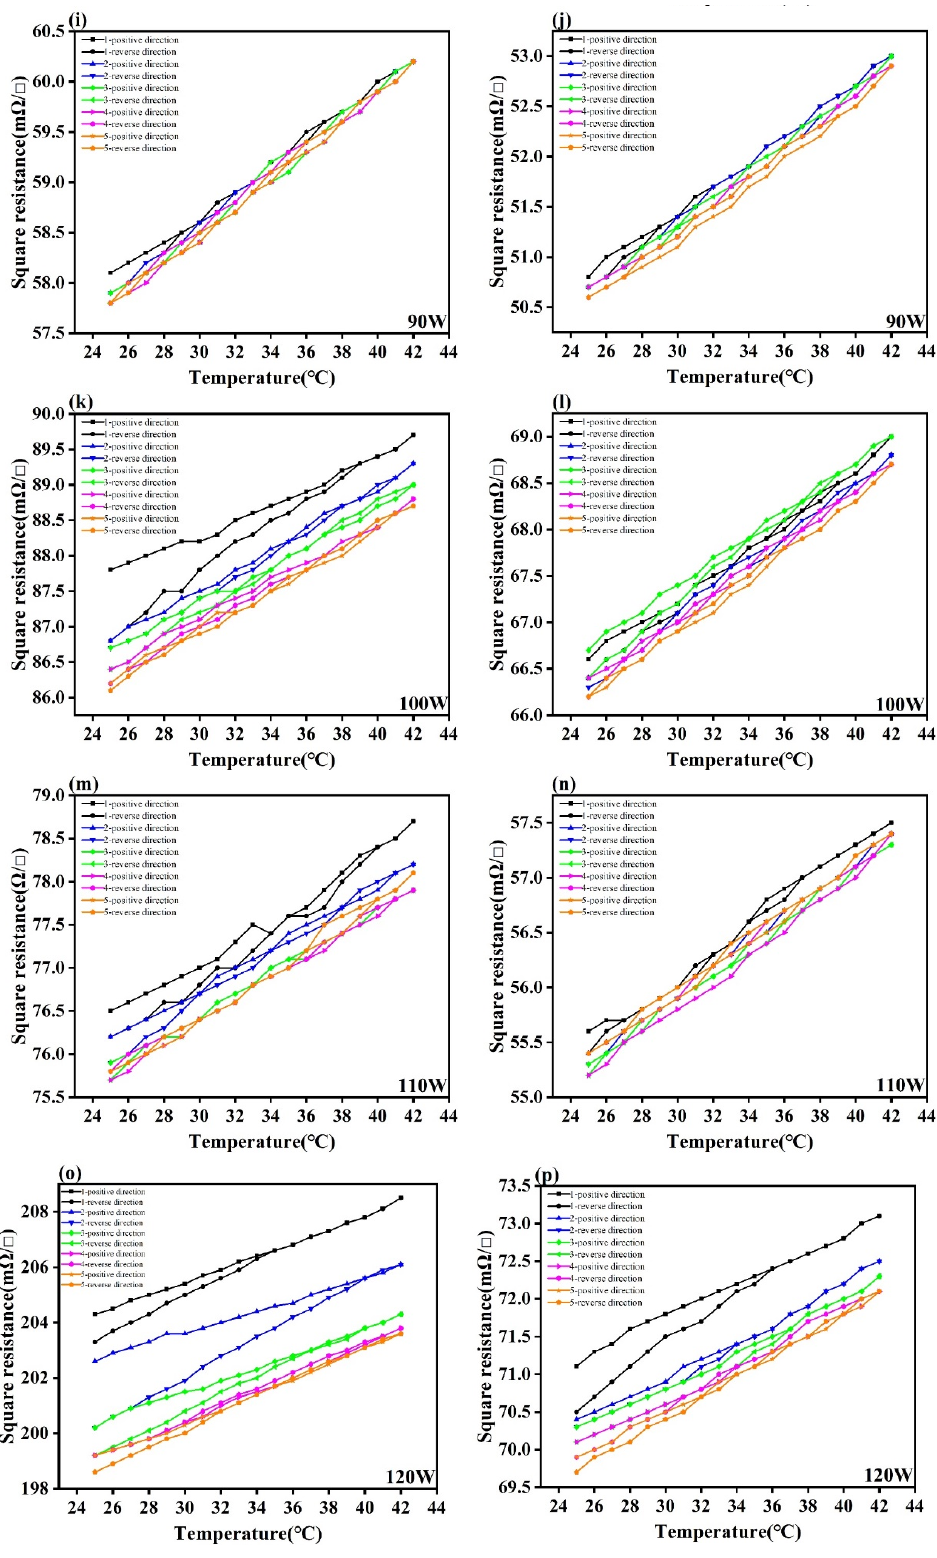
Figure 5. Left column—hysteresis curves at each power before heat treatment; right column—hysteresis curves at each power after heat treatment. ( a ) Hysteresis curves of Ag layer before heat treatment at 50 W; ( b ) Hysteresis curves of Ag layer after heat treatment at 50 W; ( c ) Hysteresis curves of Ag layer before heat treatment at 60 W; ( d ) Hysteresis curves of Ag layer after heat treatment at 60 W; ( e ) Hysteresis curves of Ag layer before heat treatment at 70 W; ( f ) Hysteresis curves of Ag layer after heat treatment at 70 W; ( g ) Hysteresis curves of Ag layer before heat treatment at 80 W; ( h ) Hys ‐ teresis curves of Ag layer after heat treatment at 80 W; ( i ) Hysteresis curves of Ag layer before heat treatment at 90 W; ( j ) Hysteresis curves of Ag layer after heat treatment at 90 W; ( k ) Hysteresis curves of Ag layer before heat treatment at 100 W; ( l ) Hysteresis curves of Ag layer after heat treatment at 100 W; ( m ) Hysteresis curves of Ag layer before heat treatment at 110 W; ( n ) Hysteresis curves of Ag layer after heat treatment at 110 W; ( o ) Hysteresis curves of Ag layer before heat treatment at 120W; ( p ) Hysteresis curves of Ag layer after heat treatment at 120 W.